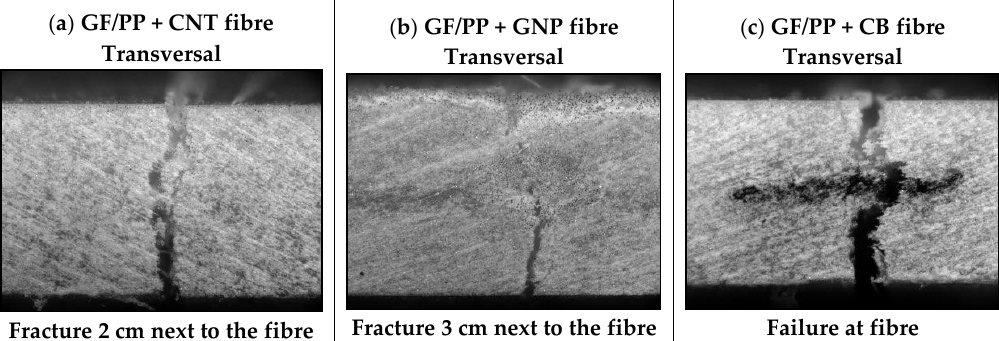
Figure 10. Fracture patterns of unidirectional PP/GF hybrid yarn composite with an embedded sensor fibre bundle (transversal tensile test, type B); horizontal tensile direction.